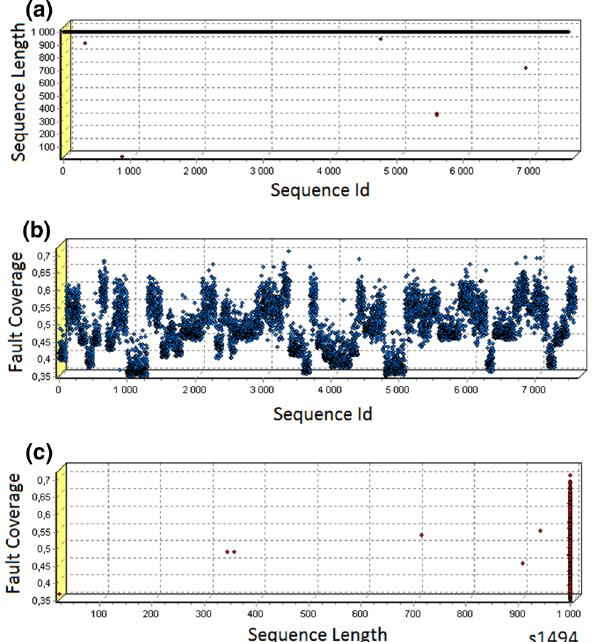
Fig. 19 Simulation graph for s1494 a sequence length vs. sequence id, b FC vs. sequence id and c FC vs. sequence length. STP (Id 1–7500),